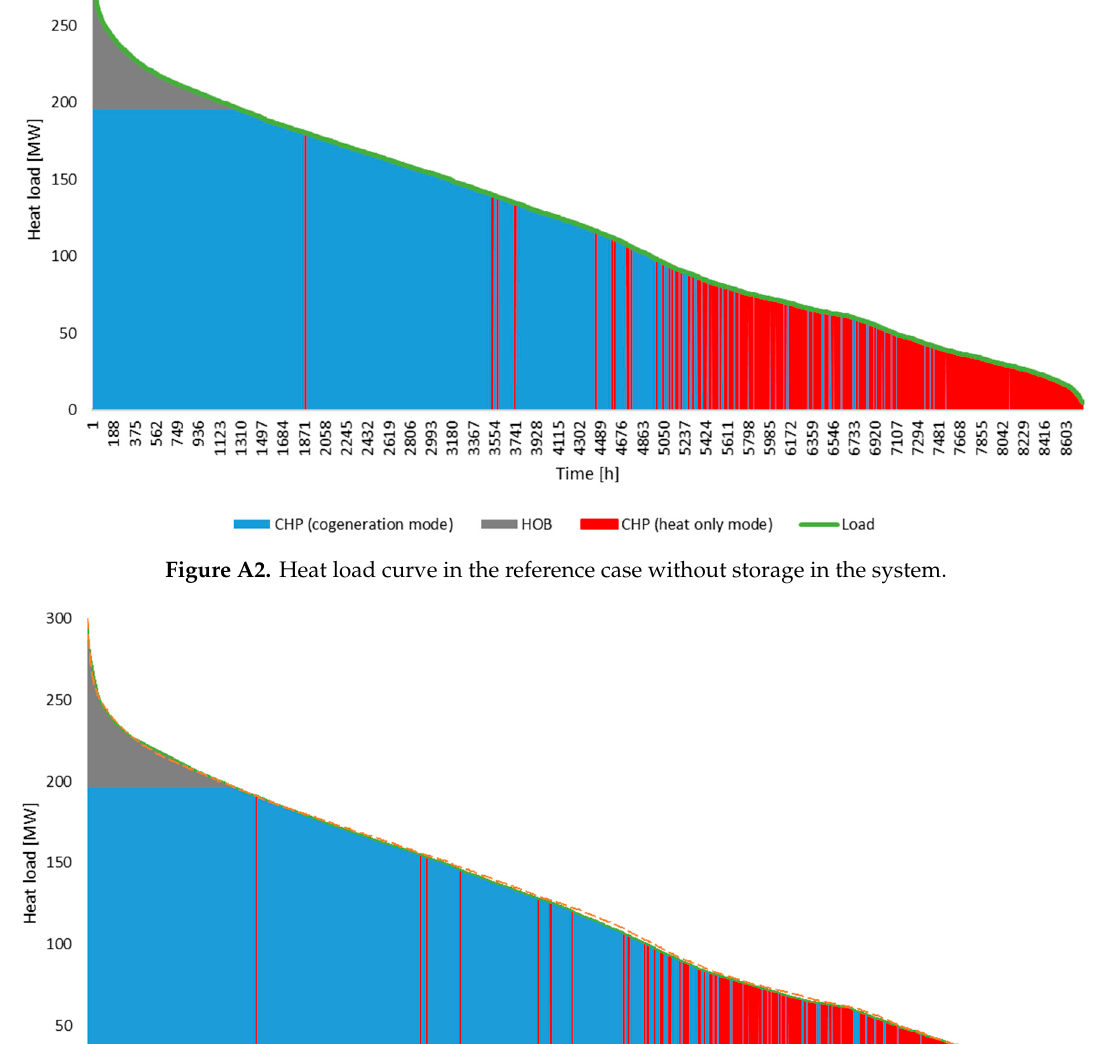
Figure A1. Relative load variation for the simulated year.